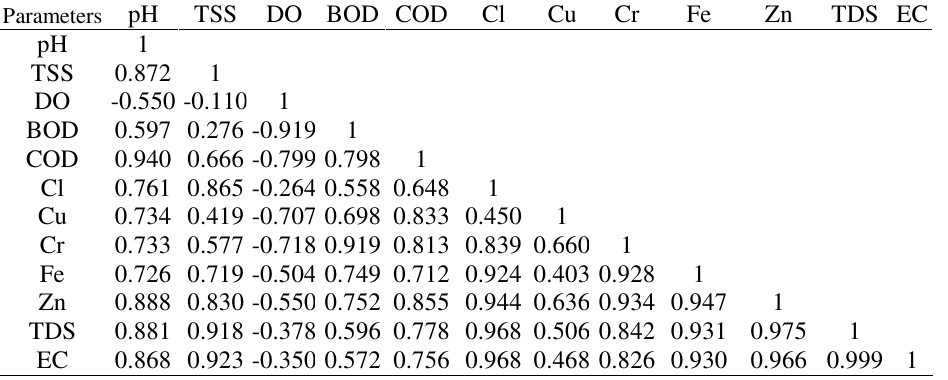
Table 4. Relationship between wastewater quality